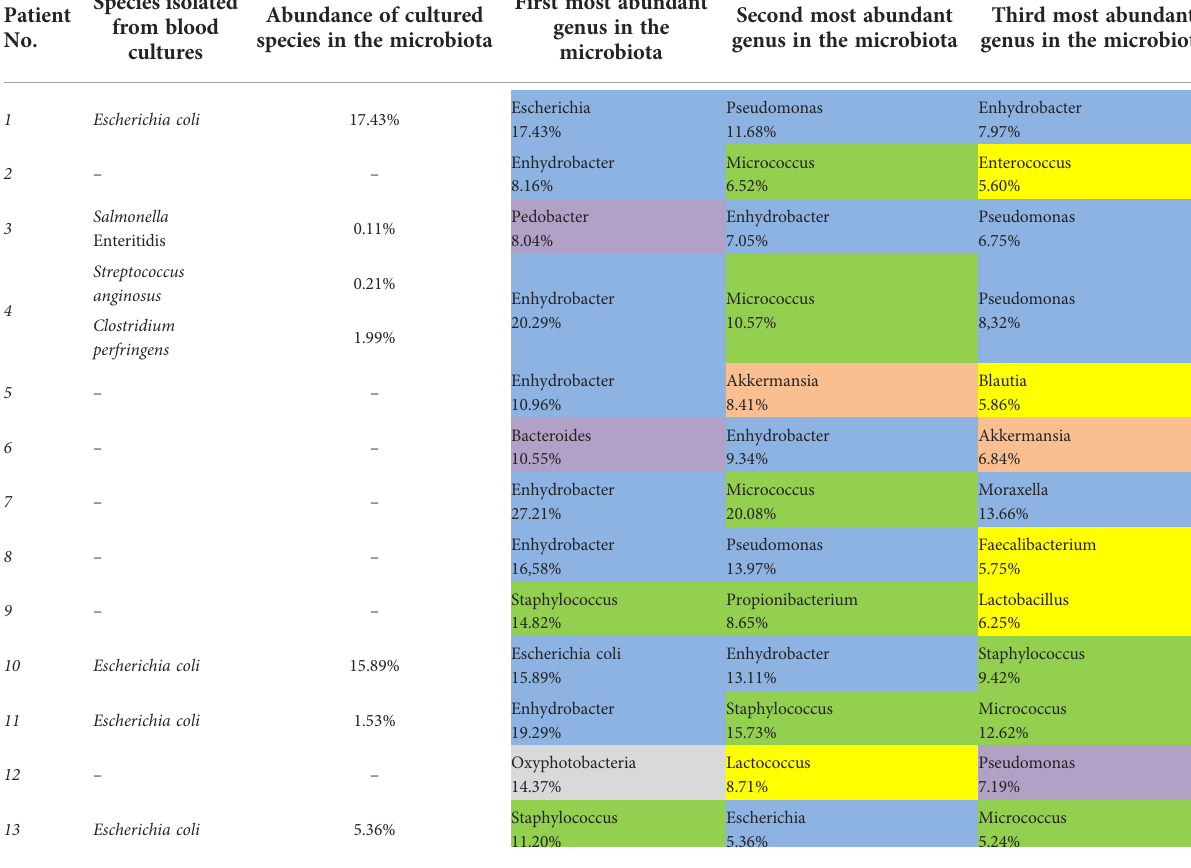
TABLE 3 Results of species isolated from blood cultures and abundance during microbiota analysis in septic patients. Patient